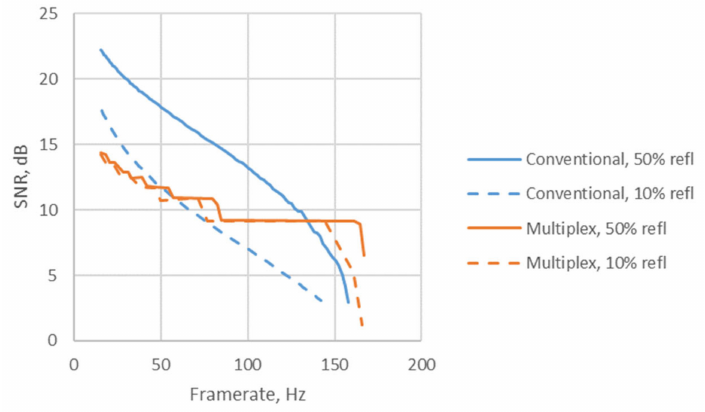
Figure 10. Shows the SNR behavior of the conventional spectrograph sensing vs. the CA multiplexed sensing for the VNIR sensing system, at an illumination of 60 ◦